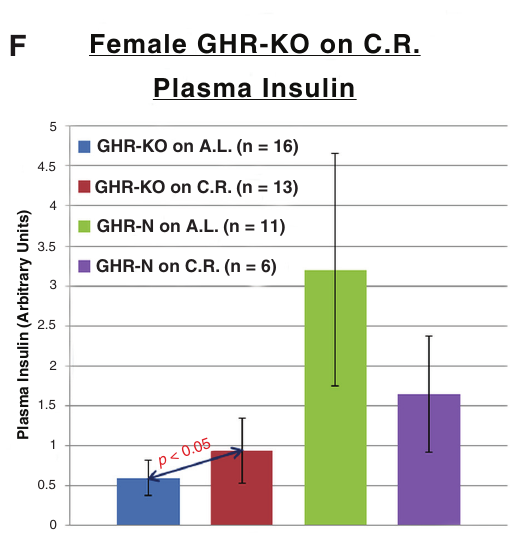
Figure 2. Endocrinological assessment of effect of 30% caloric restriction on GHR-KO mouse. A. 30% caloric restriction does not affect body weight immediately preceding a tolerance or conversion test for GHR-N or GHR-KO females. B. 30% caloric restriction partially corrects the glucose intolerance of female GHR-KO mice under A.L.-fed conditions (including repeated-measures statistical analysis table). C. 30% caloric restriction does not affect the glucose intolerance of GHR-KO females under fasted conditions (including repeated-measures statistical analysis table). D. 30% caloric restriction corrects the enhanced insulin sensitivity of female GHR-KO mice (including repeated- measures statistical analysis table). E. 30% caloric restriction does not significantly alter the heightened de novo hepatic glucose production of GHR-KO females (including repeated-measures statistical analysis table). F. 30% caloric restriction increases plasma insulin in female GHR-KO